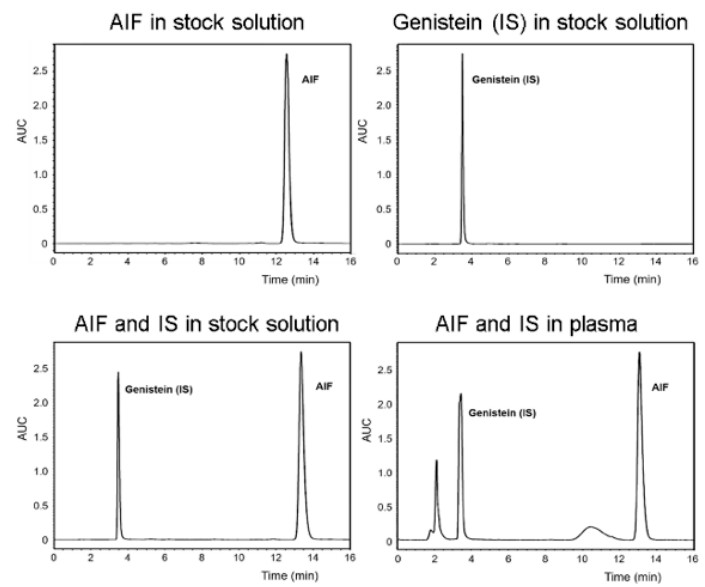
Figure 1. Representative chromatograms of alpinumisoflavone (AIF) and genistein (internal standard [IS]) in stock solution and biological sample.